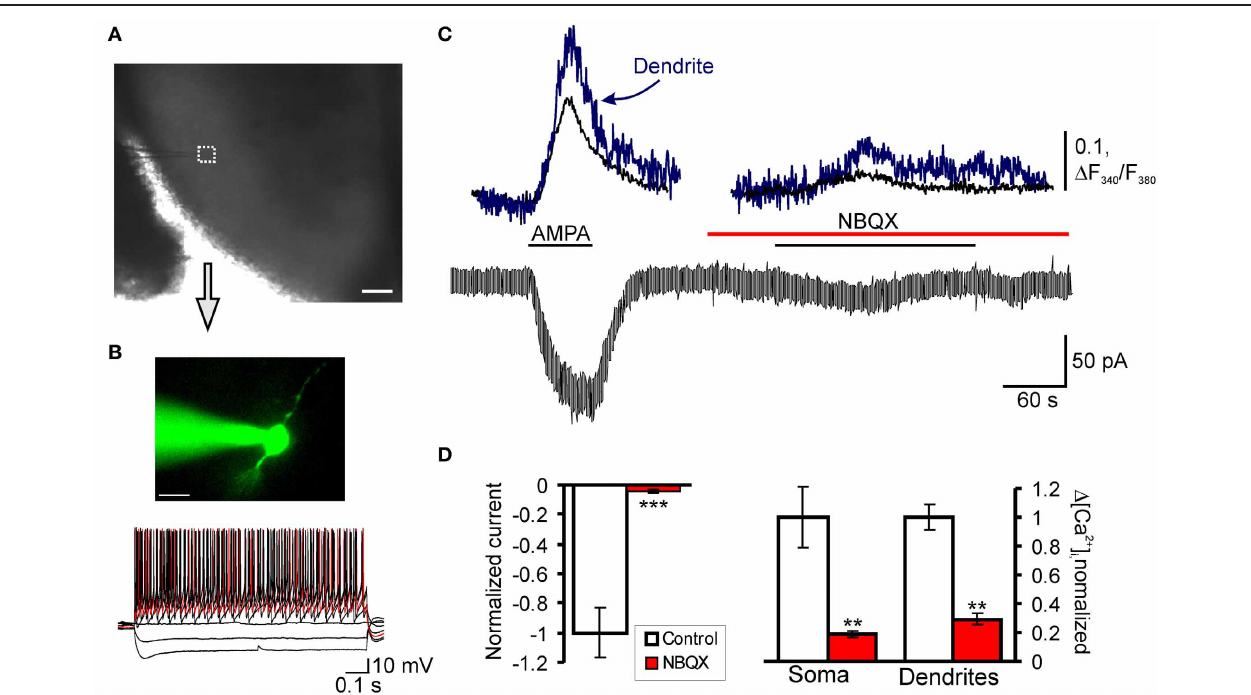
recorded from the soma in tonic neurons during AMPA bath application (5 μ M) before and after pre-application of AMPAR antagonist NBQX (30 μ M). (D) A statistical summary of the AMPA-induced current amplitudes (left graph) and [Ca 2 + ] i transients (right graph) in soma and dendrites of SG neurons before and after pre-application of AMPAR antagonists NBQX. ∗∗ p < 0 . 01, ∗∗∗ p < 0 . 001 versus